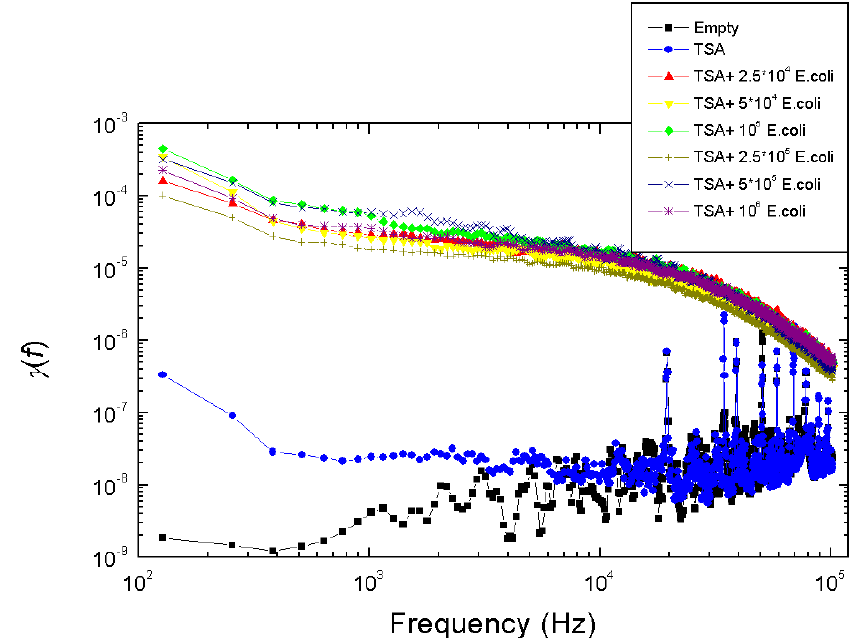
Figure 9. Variations of the normalized power density spectrum at different bacterium numbers.